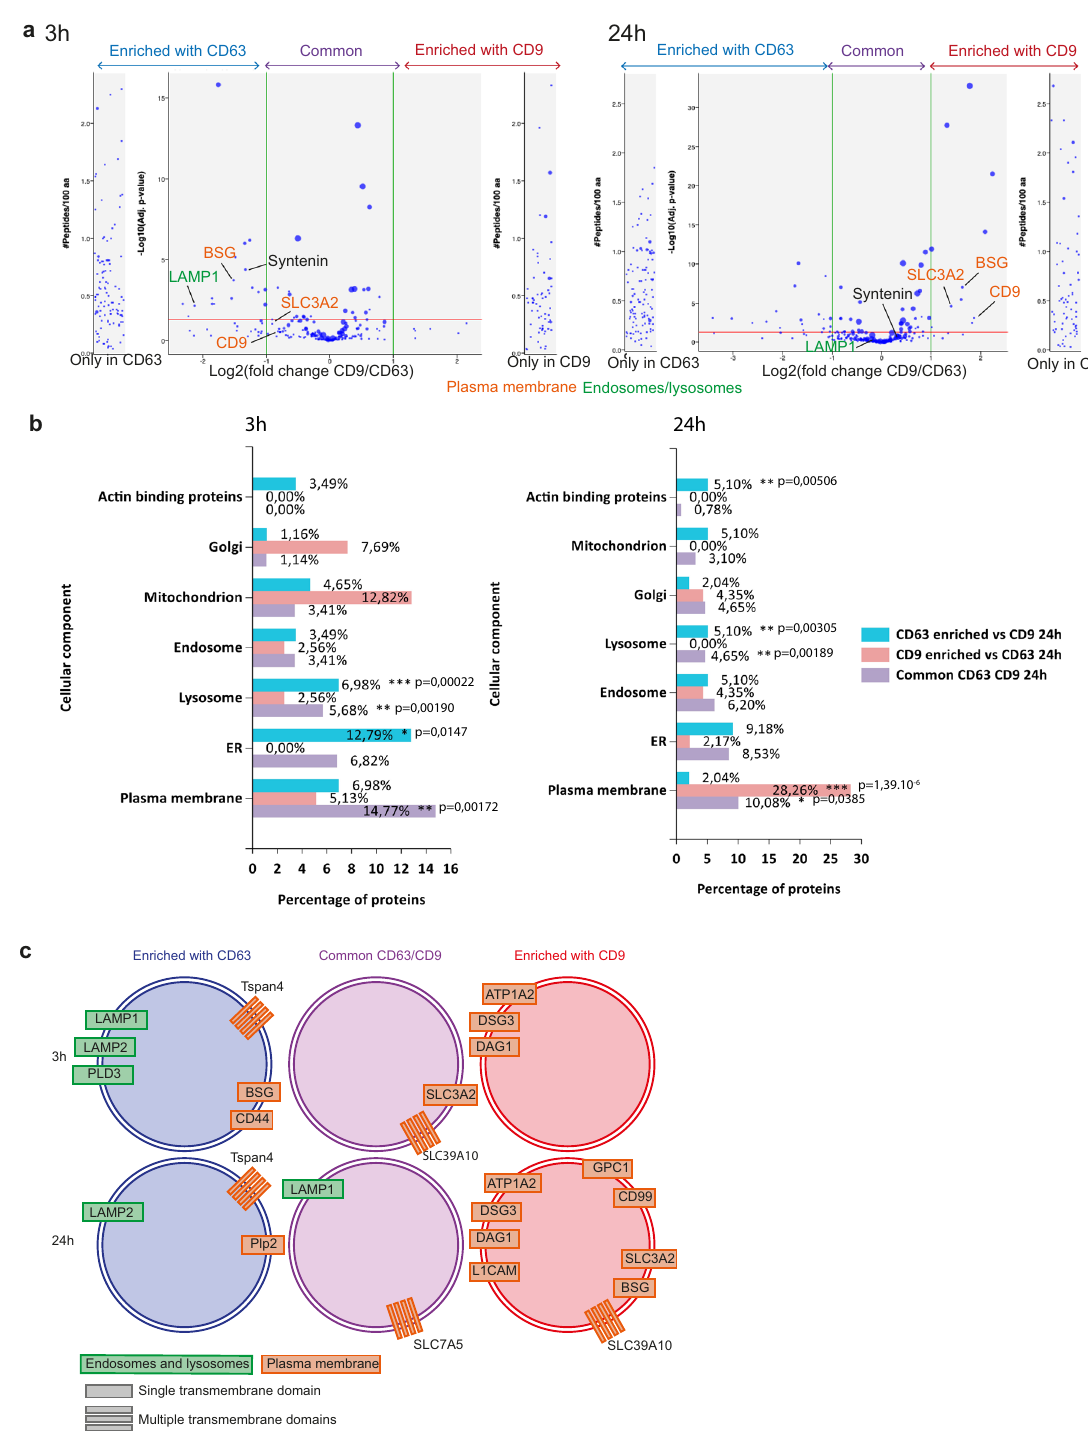
Fig. 6 Quantitative proteomic analysis of CD63-eGFP-RUSH and CD9-eGFP-RUSH EVs. EVs were isolated by anti-GFP immuno-isolation from either non-transfected HeLa cells, or HeLa transfected with CD63-eGFP -RUSH or CD9-eGFP -RUSH, either 3 h or 24 h after biotin addition, and their composition was analyzed by mass-spectrometry. a Volcano plots representing quanti fi ed proteins with at least 2 peptides in 2 replicates in at least one condition. Shown are the fold changes of peptide abundancy between CD63- and CD9-eGFP expressing EV samples and the p -value of this quanti fi cation, for EVs recovered 3 h (left) or 24 h (right) after biotin addition. Position of the membrane-associated proteins selected for further analysis is indicated. b Results of the FunRich gene enrichment analysis among the proteins either enriched in the CD63- (blue), or CD9-eGFP (red) samples, or common between the CD63 and CD9-eGFP samples (purple) at 3 h or 24 h after biotin addition. For each subcellular compartment protein list, % of proteins of this category in the list of CD63-, CD9-, or common CD63/CD9 proteins is indicated, and the p -value of this percentage being different to its counterpart in the whole HeLa cell database is calculated. P -value (hypergeometric uncorrected). c Schematic representation of the transmembrane proteins identi fi ed in the CD63-, CD9-, or CD63/CD9-eGFP EVs at 3 h and 24